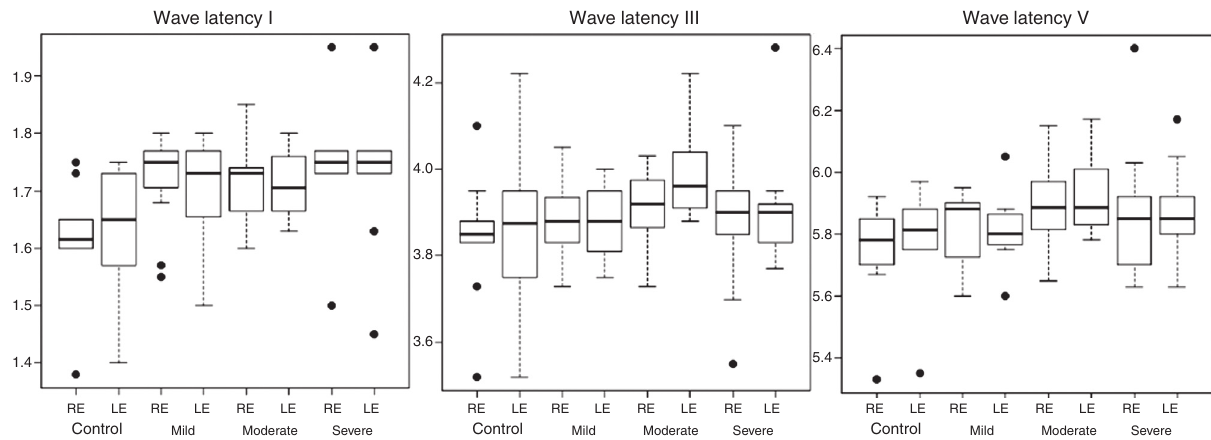
Absolute latencies of waves I, III and V (in milliseconds) according to the side of the ear and group.